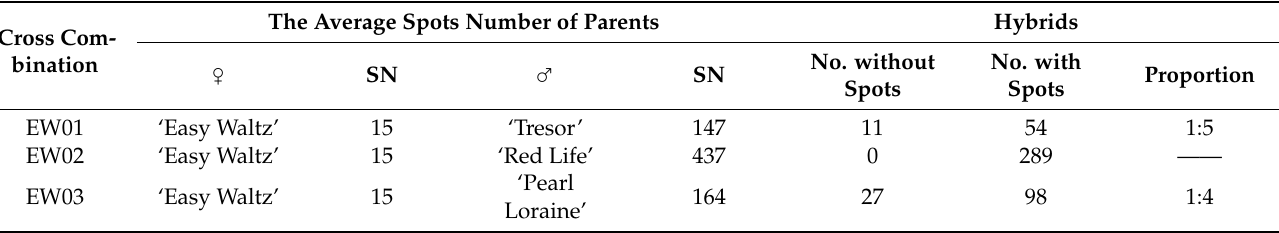
Table 3. The spot numbers of cross parents and different hybrid populations.